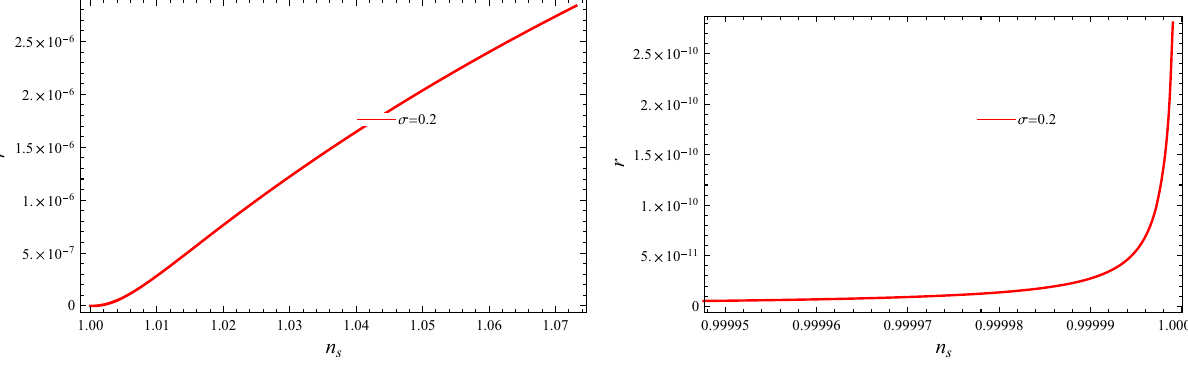
Fig. 18 Plot of r versus n s for GCCG model in weak (left panel) and strong (right panel) dissipative regimes for negative potential with n = − 2 Table 6 GCCG weak and Sr. no strong dissipative regime with positive quadratic and quartic potential